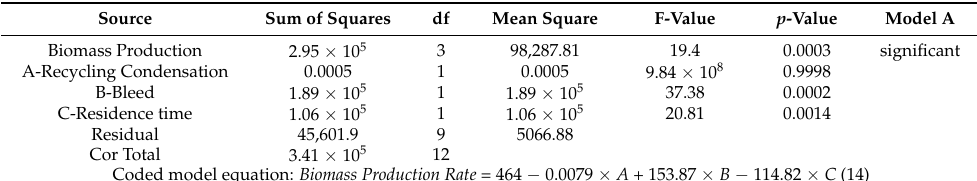
Figure 3. Surface response plots of biomass production rate in relation to: ( a ) bleed and recycle condensation; ( b ) bleed and residence time; ( c ) residence time and recycle condensation. Table 4. Design of experiment statistical models for the response biomass production rate (g/h) against factorials bleed (%) and residence time